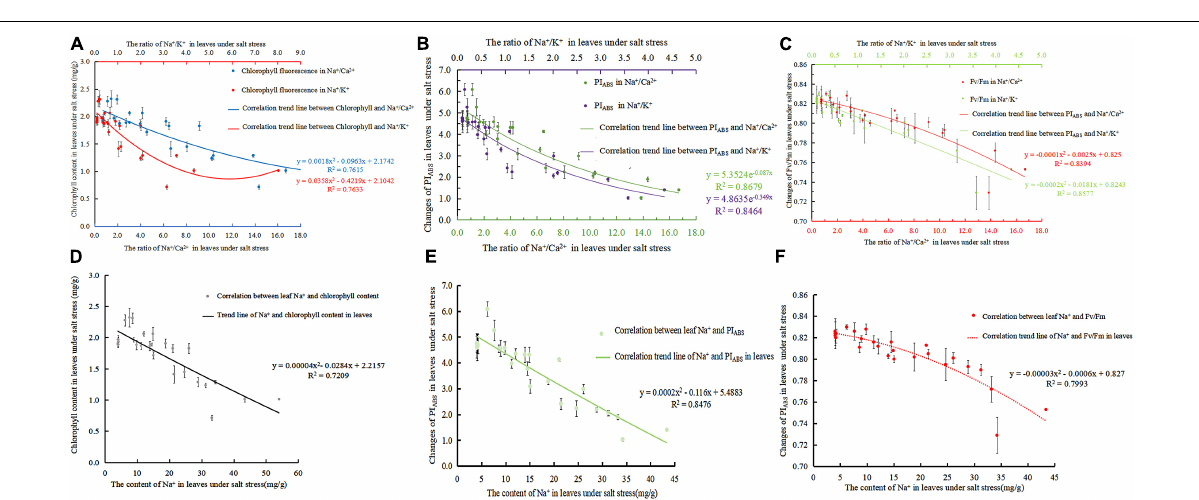
FIGURE 3 | The ion ratio of salt stress to leaves was correlated with chlorophyll and fluorescence parameters; (A) correlation of Na + / Ca 2 + and Na + / K + to chlorophyll content in the leaves of S. matsudana under salt stress; (B) correlation between Na + /Ca 2 + , Na + / K + , and PI ABS in the leaves of S. matsudana under salt stress; (C) correlation of Na + /Ca 2 + and Na + /K + in the leaves of Salix matsudana with Fv/Fm under salt stress; (D) correlation between Na + and chlorophyll content in S. matsulosa leaves under salt stress; (E) correlation between Na + and PI ABS in S. matsulosa leaves under salt stress; (F) correlation between Na + and Fv/Fm in S. matsulosa leaves under salt